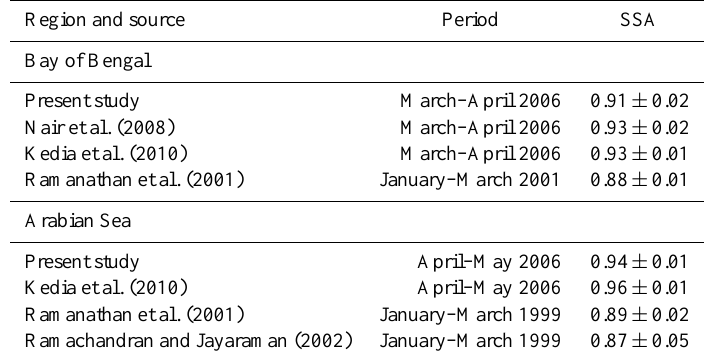
Fig. 6. Comparison of (a) modelled absorption optical depth (AAOD) at 550 nm and (b) Aura-OMI satellite derived AAOD at 500 nm averaged over the ICARB 2006 period. The simulated contributions of (c) BC and (d) Dust plus OC, to total AAOD, respectively, are also shown. Table 6. Mean single scattering albedo (SSA) over the Bay of Bengal and Arabian Sea region obtained from present study in comparison with earlier